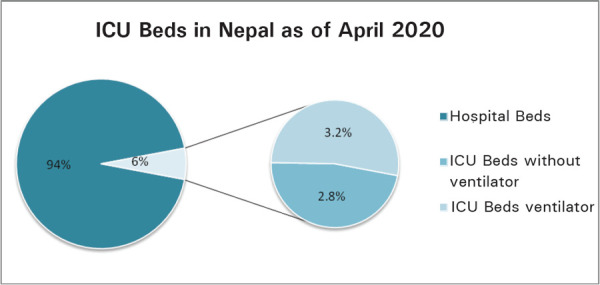
ICU Beds in Nepal.